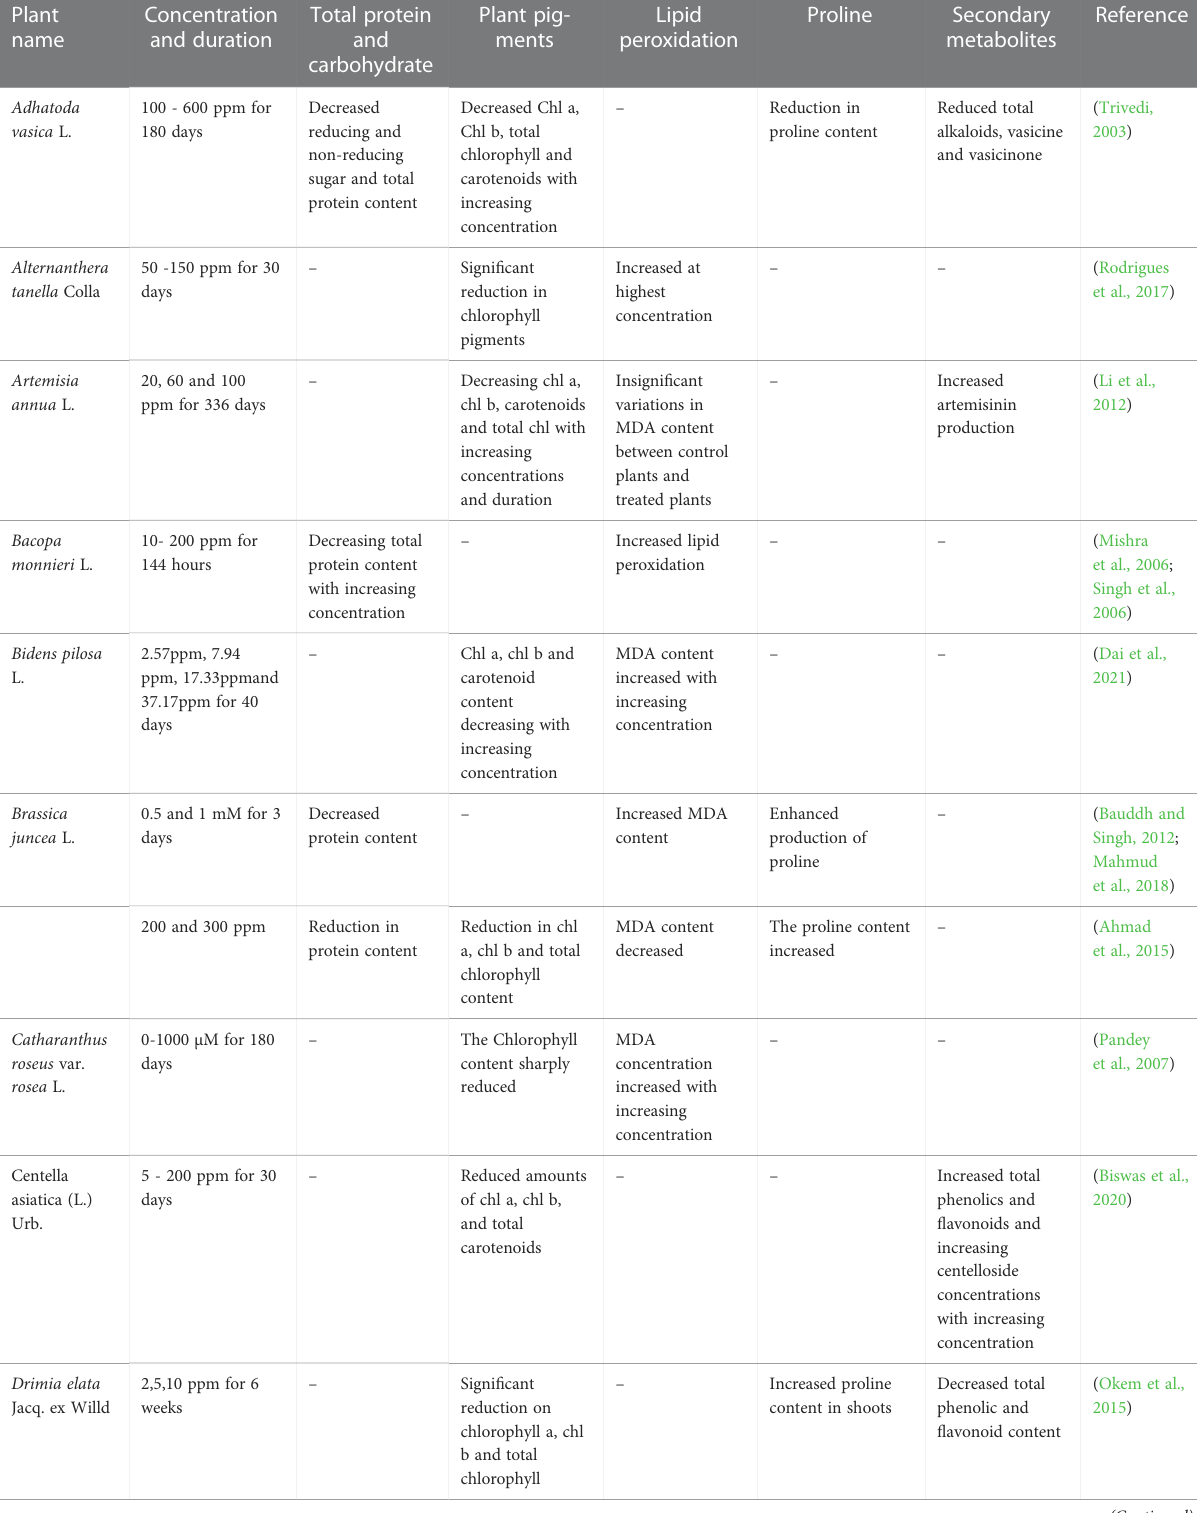
TABLE 3 Changes in photosynthetic pigments and biochemical parameters in cadmium treated medicinal